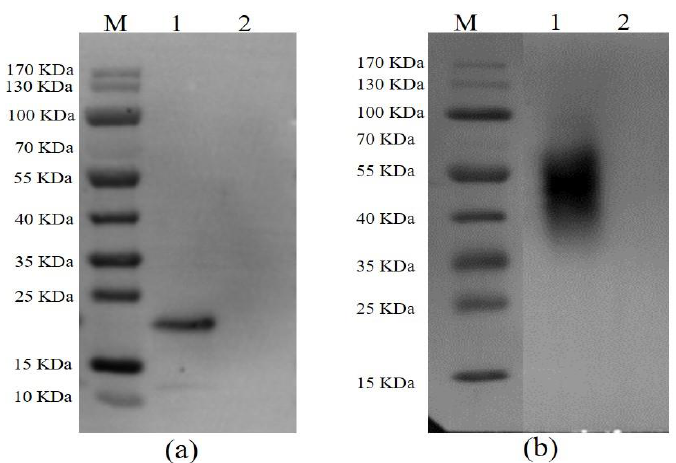
Figure 1. Western blot analysis of p54 ( a ) and CD2v ( b ) with pig anti-ASFV polyclonal antibody. In both figures, lane M is protein molecular weight marker, lane 1 shows the purified fusion protein, and lane 2 is pET-30a empty vector used as a control.